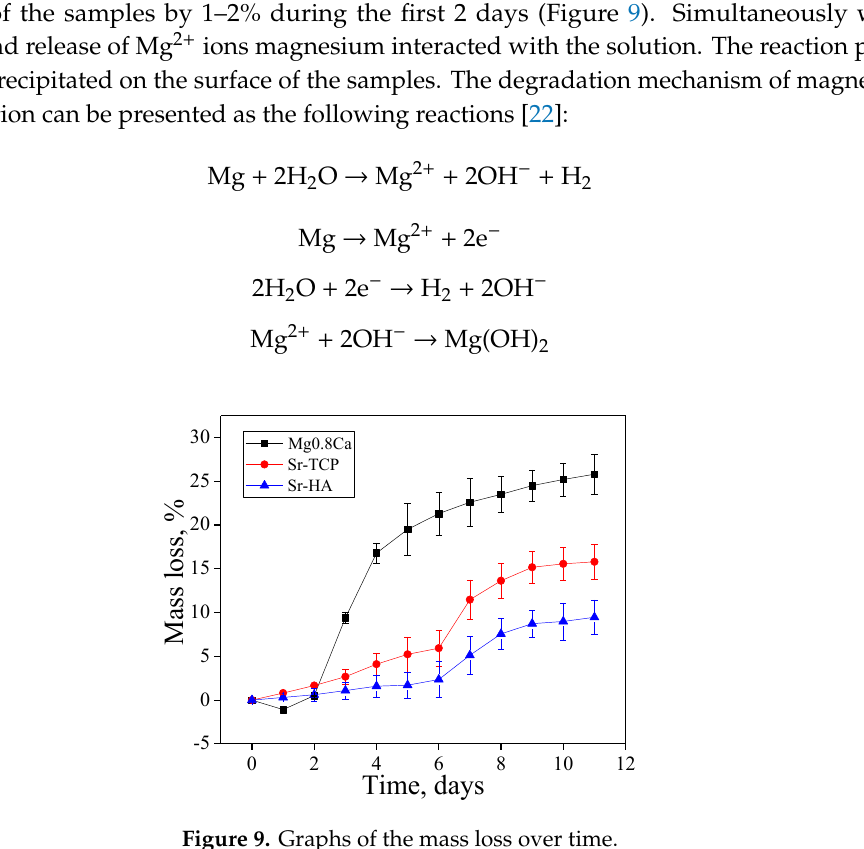
Figure 8. Diagrams of the (Ca + Mg + Sr)/P ratio against the applied voltage for the Sr-HA ( a ) and Sr-TCP ( b ) coatings.